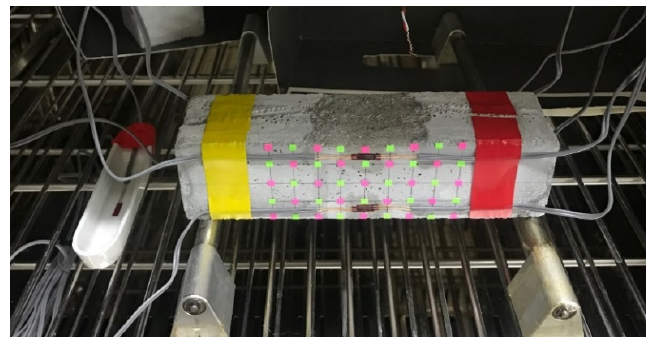
Figure 14. Test set-up. Appl. Sci. 2020 , 10 , x FOR PEER REVIEW